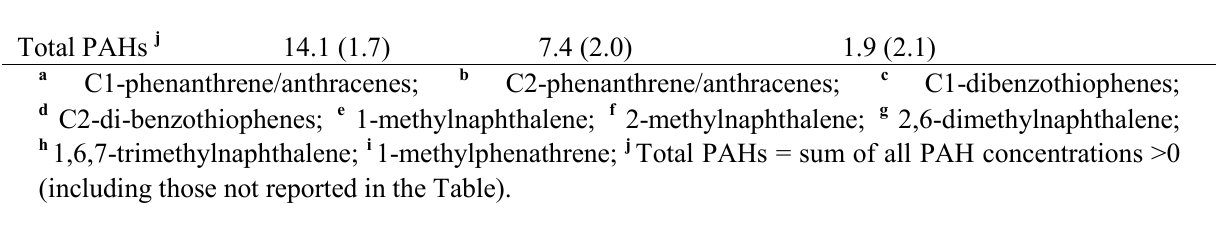
Table 4. Summary statistics for PAH concentrations in matched pairs of maternal and cord blood collected within 24-hours of each other (N =